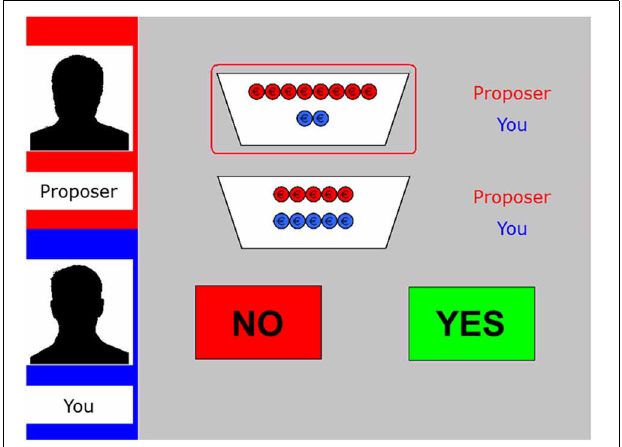
FIGURE 1 | Display of the decision phase in the fair-alternative condition of the modified UG. The left panel shows the name and silhouette of the proposer at the top (here “Proposer”) as well as the name of the participant underneath (here “You”). The two potential distributions are specified by red and blue coins (red for the proposer, blue for the responder; here 8:2 vs. 5:5). The selected offer is encircled in red. The participant has to decide whether to accept (“Yes”) or reject (“No”) the offer via button press.